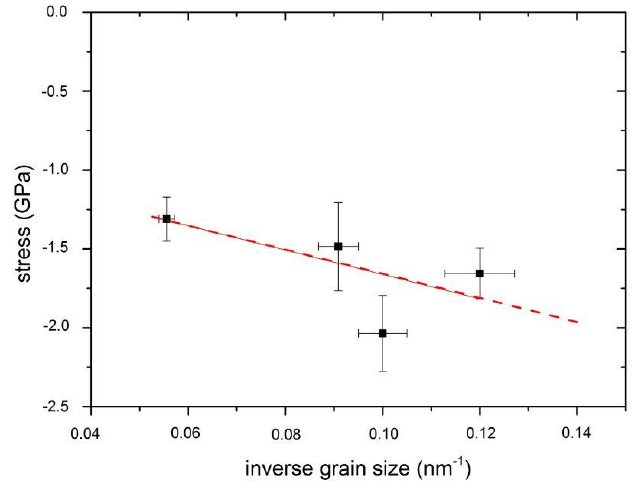
Figure 2. Compressive stress as a function of inverse grain size. Table 2. Coefficient of friction and wear factor measured applying normal load of 5, 10, and 15 N at sliding speed of 2